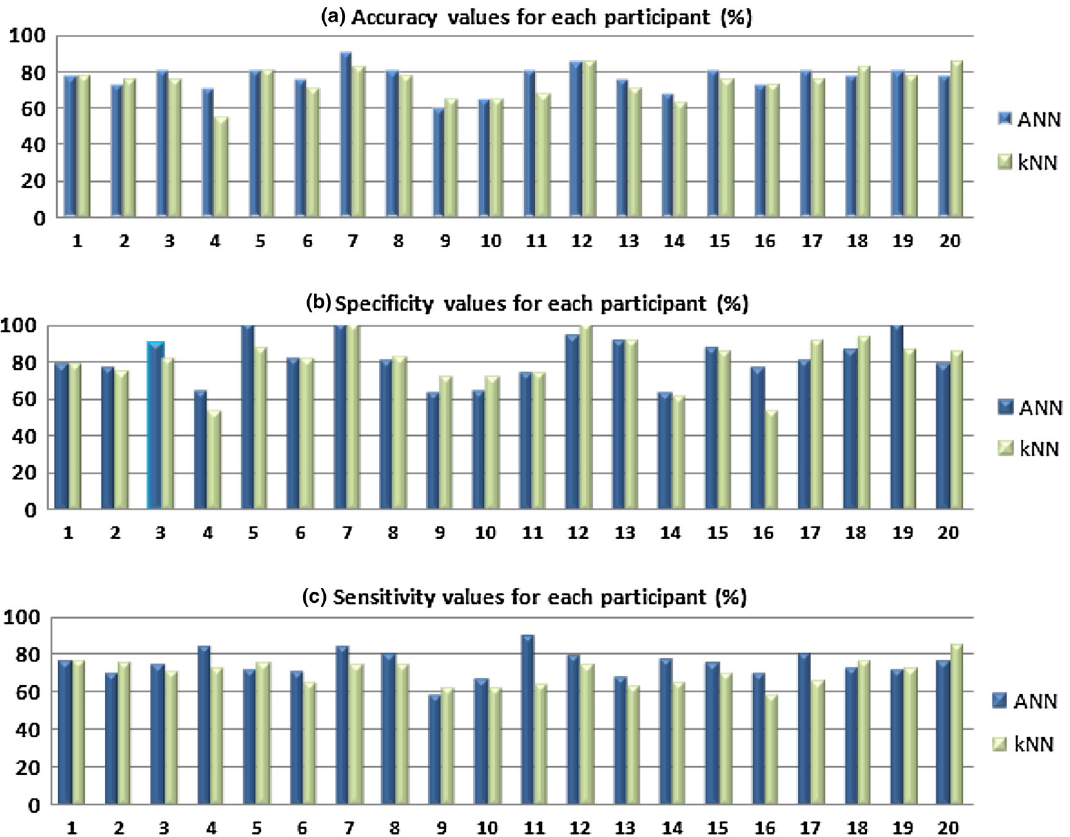
Fig. 9 Comparison of classification performances for each participant in terms of, a accuracy, b specificity and, c sensitivity ( x - axis — participants, y-axis